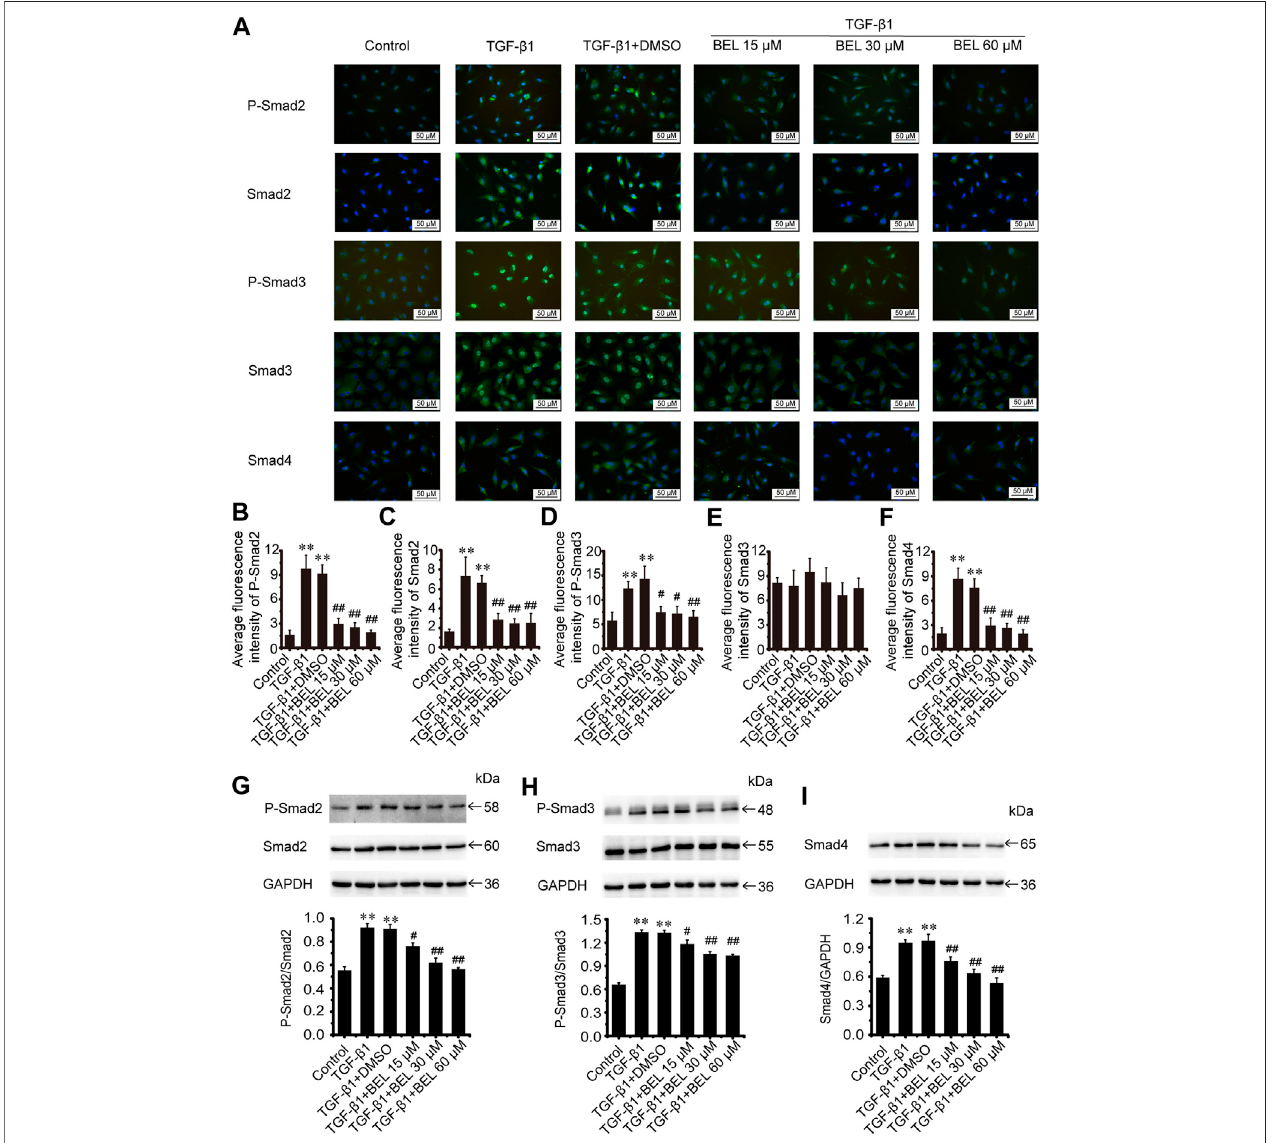
FIGURE 7 | BEL inhibits Smads signaling in CFs (A) The effects of different doses of BEL (15, 30, 60 μ M) on the expression of Smads2, 3, and 4 and the level of P-Smads2, 3 induced by TGF- β 1 using immuno fl uorescence staining. Cell nuclei was counterstained in blue with DAPI (B – F) Bar graphs show quantitative analyses of fl uorescent signals for P-Smads2, Smads2, P-Smads2, Smad3, and Smad4 (G – I) Western blotting detects Smad proteins expression and phosphorylation levels. Bar graphsshowfoldchangesofP-Smad2/Smad2,P-Smad3/Smad3,andSmad4/GAPDH( n (cid:2) 3).Datawereshownasmean ± SEM.** p < 0.01vs.control, # p <